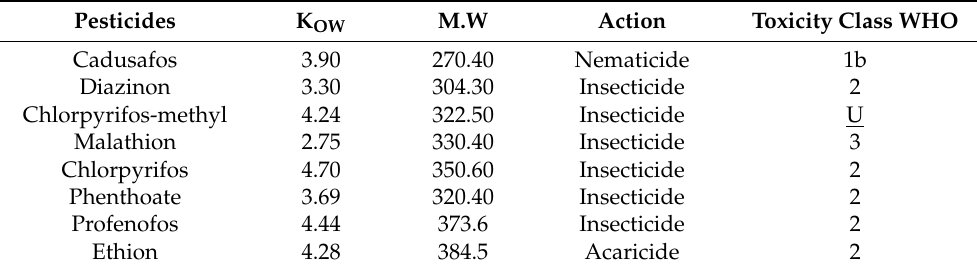
Table 1. OPPs are considered non-persistent (shorter half-life) due to rapid degradation in the environment [17]. Table 1. Physical properties and toxicity class of organophosphorus pesticides [18]. Pesticides K OW M.W Action Toxicity Class WHO Cadusafos 3.90 270.40 Nematicide 1b Diazinon 3.30 304.30 Insecticide 2 Chlorpyrifos-methyl 4.24 322.50 Insecticide Malathion Chlorpyrifos Phenthoate 3.69 320.40 Insecticide Profenofos 4.44 373.6 Insecticide Ethion 4.28 384.5 Acaricide